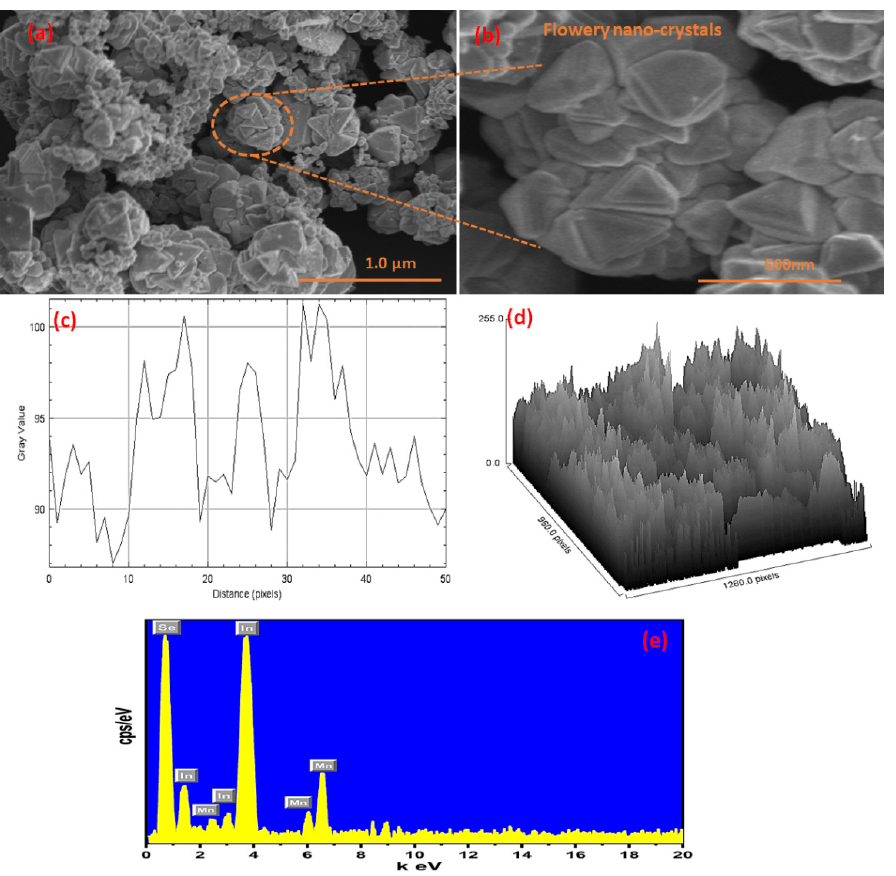
Figure 3. ( a , b ) SEM micrograph, ( c ) particle size calculated from SEM micrograph, and ( d ) Surface plot, and ( e ) EDX spectrum of the synthesized In 2 MnSe 4 nanostructure.